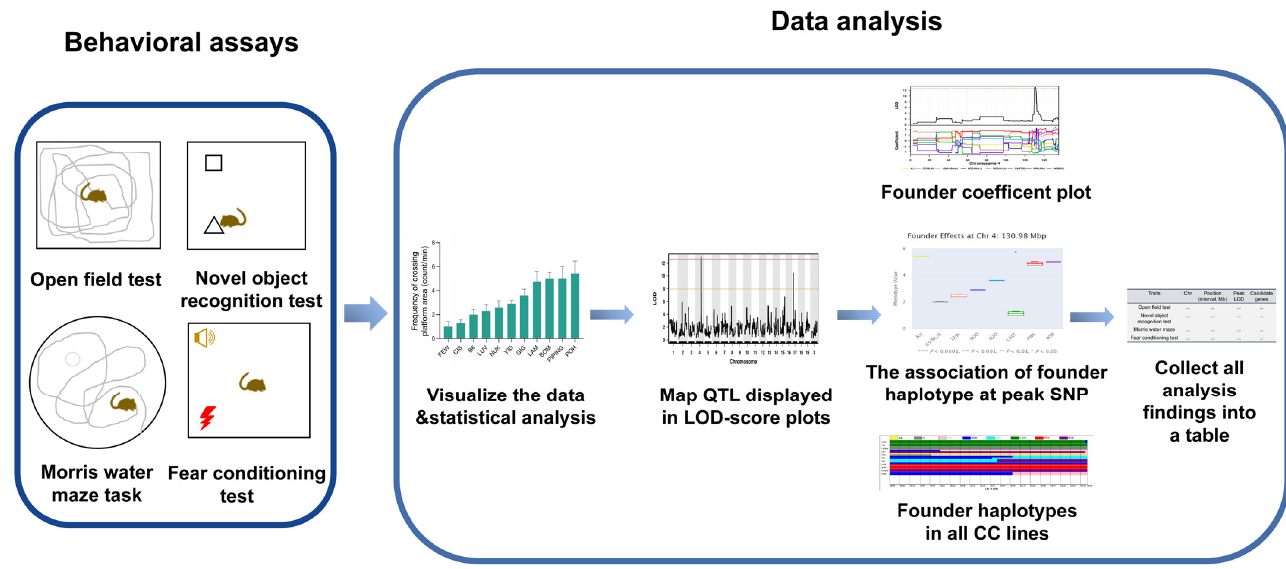
Figure 1. Illustration of the CC behavioral study workflow.